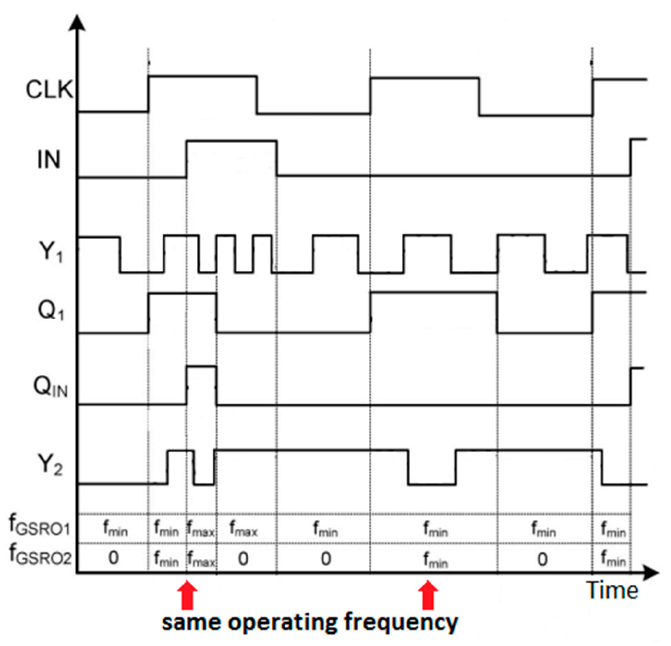
Figure 2. 1-1 Multi-stage noise-shaping (MASH) ∆∑ time-to-digital converter (TDC) architecture using GSRO [20].